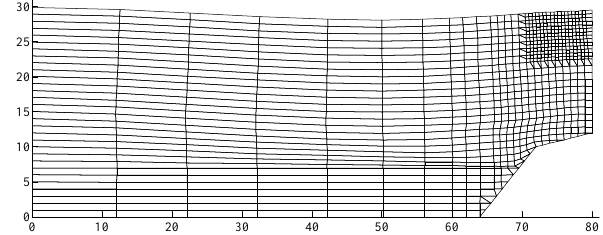
Figure 3. Deformation after consolidation.